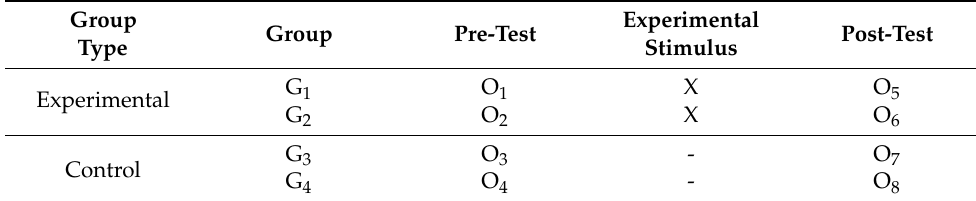
Table 12. Experimental